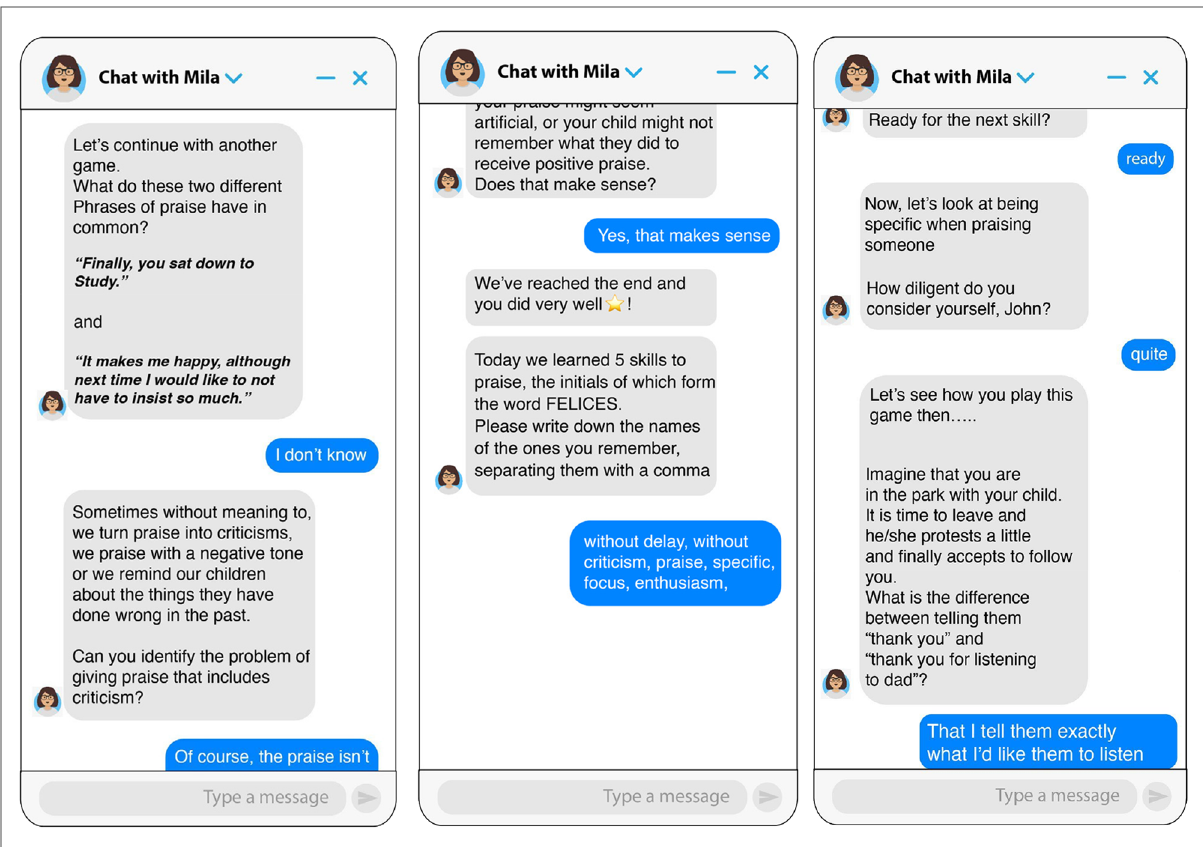
FIGURE 2 Screenshots of the chatbot for the “ Avoid combining praise with criticism ” skill and reviewing what was taught at the end of the intervention. Note. The image on the left shows skill 2 (Avoid combining praise with criticism) and the image on the right shows the review of what was taught at the end of the